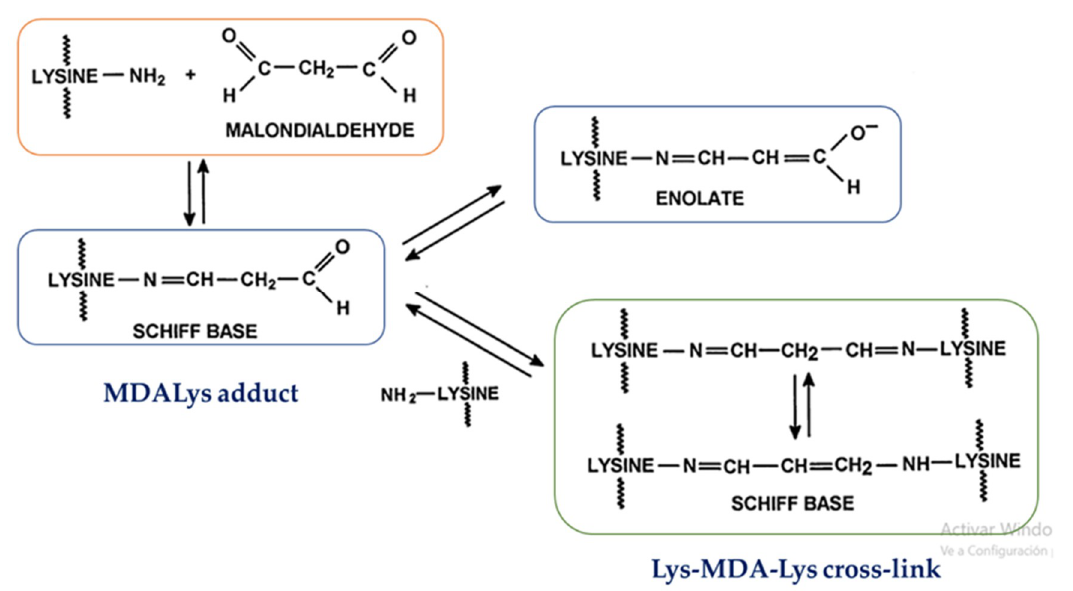
Figure 1. Formation of lysine-MDA adducts in protein. MDA is a dicarbonyl compound, which can form both mono- and di-Schiff-base adducts with lysine residues in protein, as well as enolate anions and other resonance structures. This is modified with permission from [11].